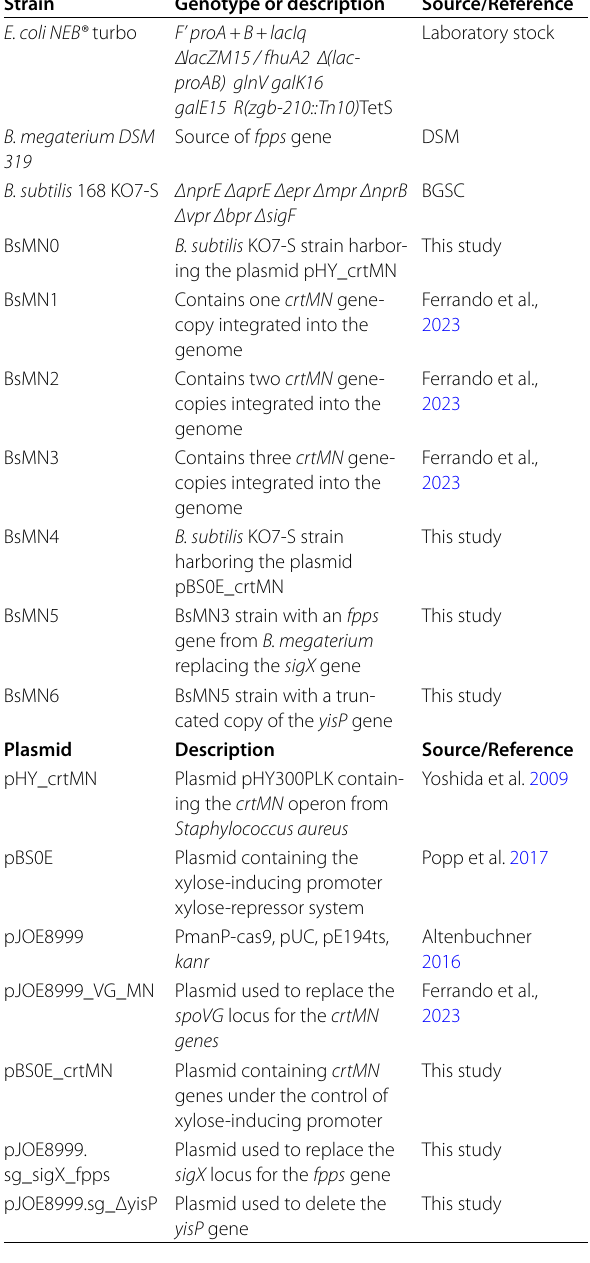
Table 1 Bacterial strains and plasmids used in this study